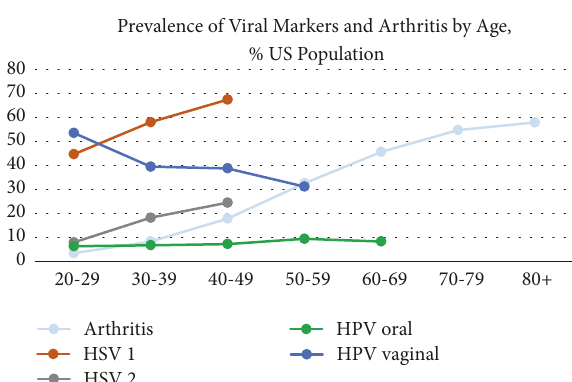
Figure 1: The prevalence of positive viral markers and arthritis by age in the US population, NHANES 2009-2012. Viral studies were collected on the full study sample with pre-determined age cutoffs: HSV-1 and HSV-2 serologies: ages 20 to 49. Oral rinse for HPV DNA, ages 20 to 69, vaginal swabs for HPV DNA, ages 20 to 59. The prevalence of self-reported arthritis and viral markers in the population varied with age. Self-reported arthritis prevalence increased with age, from 3.4% in the 2 nd decade of life to 41.9% in the 6 th decade of life, which was the age range of this study (chi-square p value < 0.001). HSV-1 and HSV-2 seropositivity increased with age (p < 0.001) and oral HPV DNA positivity increased gradually up to the 5 th decade of life and then plateaued (p = 0.045). Vaginal HPV DNA positivity declined with age (p <